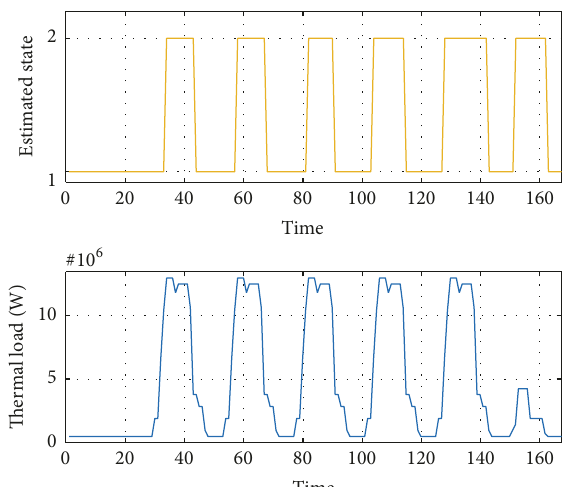
Figure 18: North zone discrete state estimation versus the actual total thermal load.